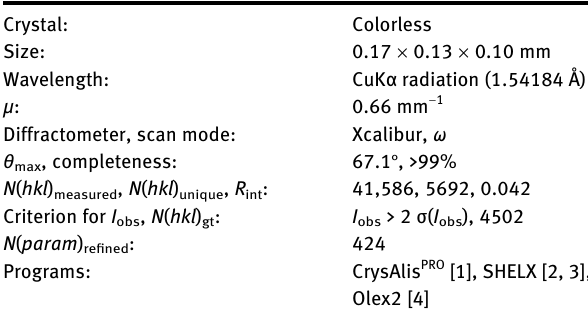
Table  : Data collection and